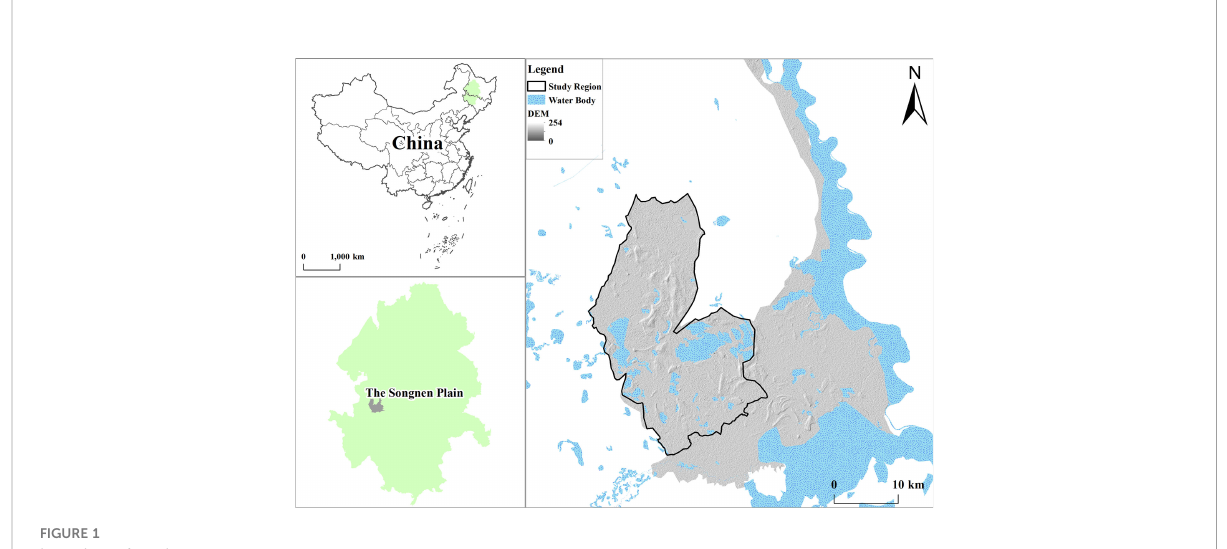
FIGURE 1 Location of study